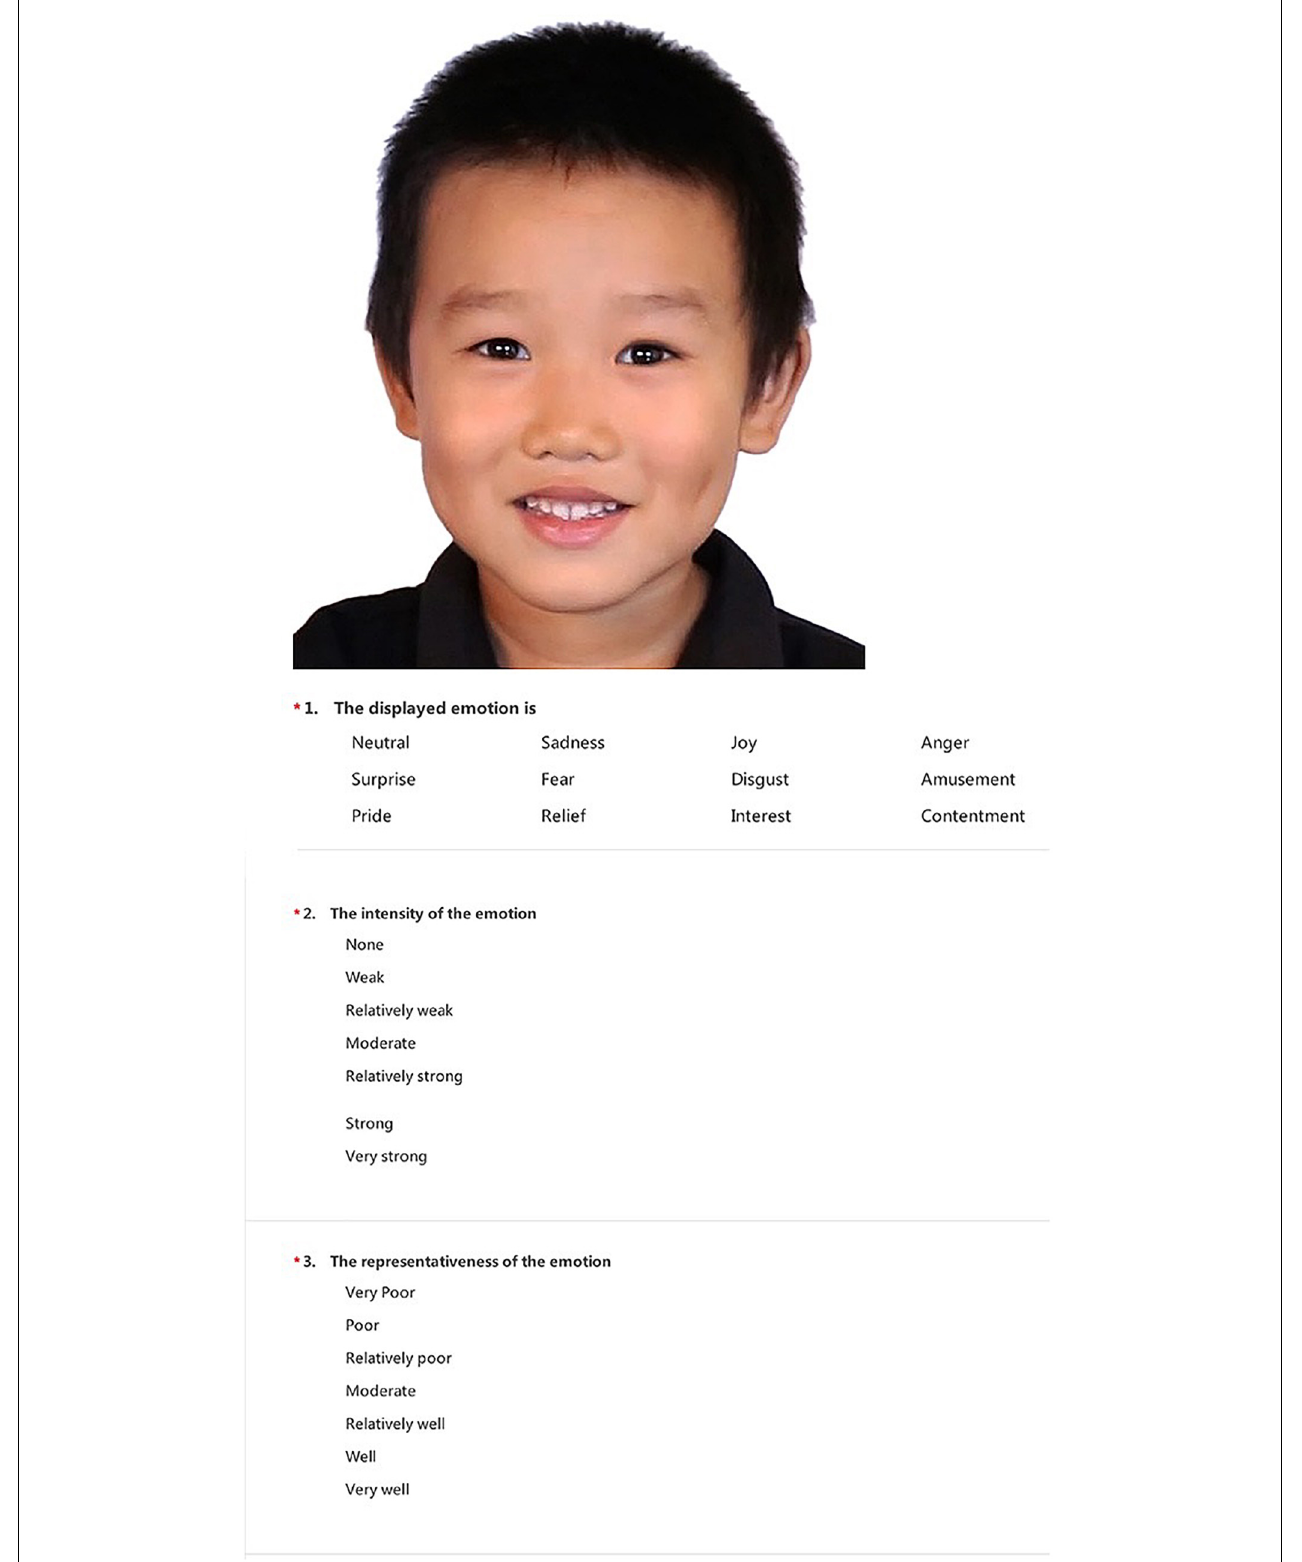
FIGURE 1 | Screenshot of an evaluation page in the